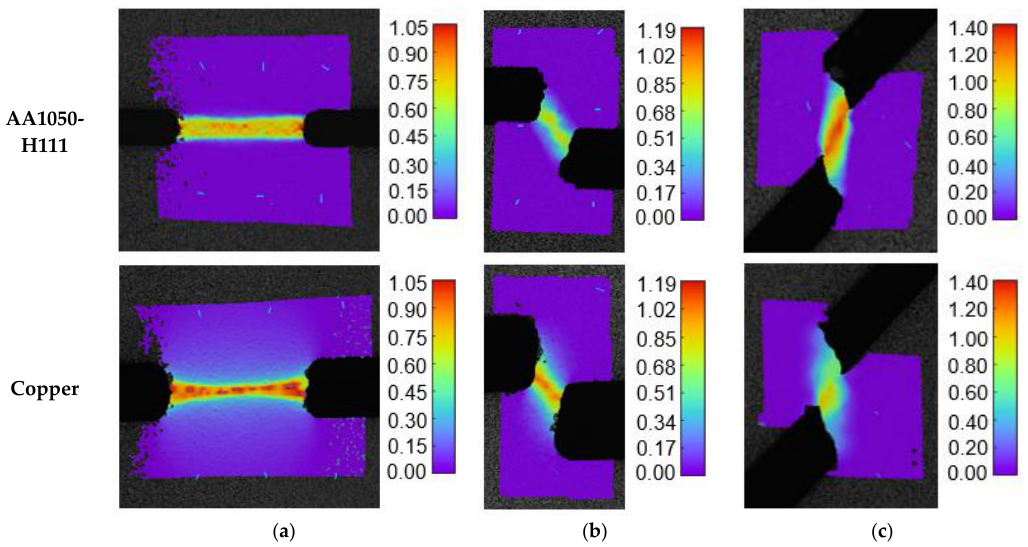
Figure 10. Experimental distribution of the major strain 𝜀 1 at the onset of fracture obtained from DIC for aluminium AA1050-H111 and copper in ( a ) DNTT ( b ) staggered DNTT with 𝛼 = 80° and ( c ) shear test specimens.